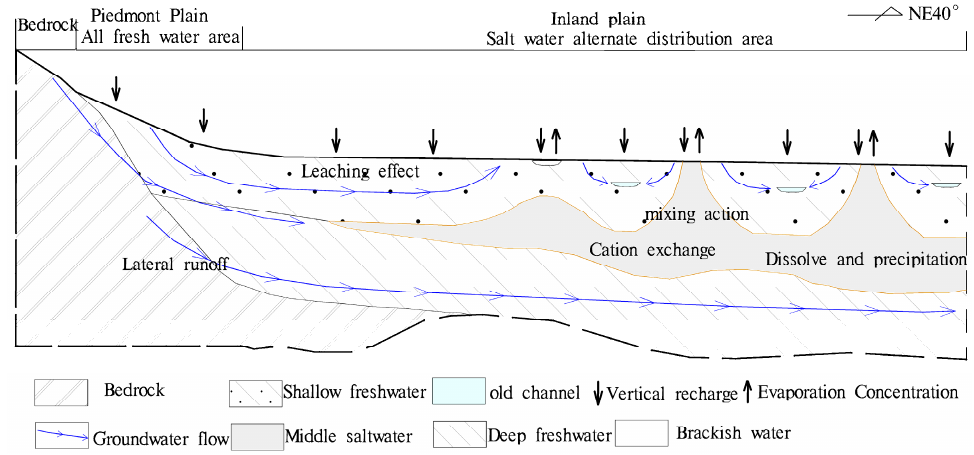
Figure 9. Dynamic characteristics of groundwater level for different types of groundwater.